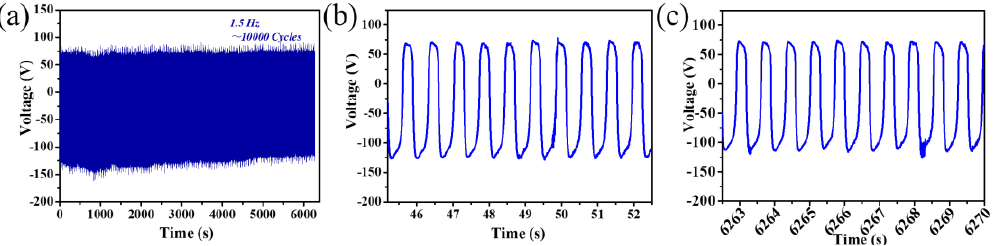
Figure 7. Long cycle stability and durability testing of flexible HO-TENG based on FSHM at 1.5 Hz motion frequency. ( a ) Stability and robustness measurement of flexible HO-TENG based on FSHM, ( b , c ) V oc at different times during the stability and robustness measurement of flexible HO-TENG based on FSHM.